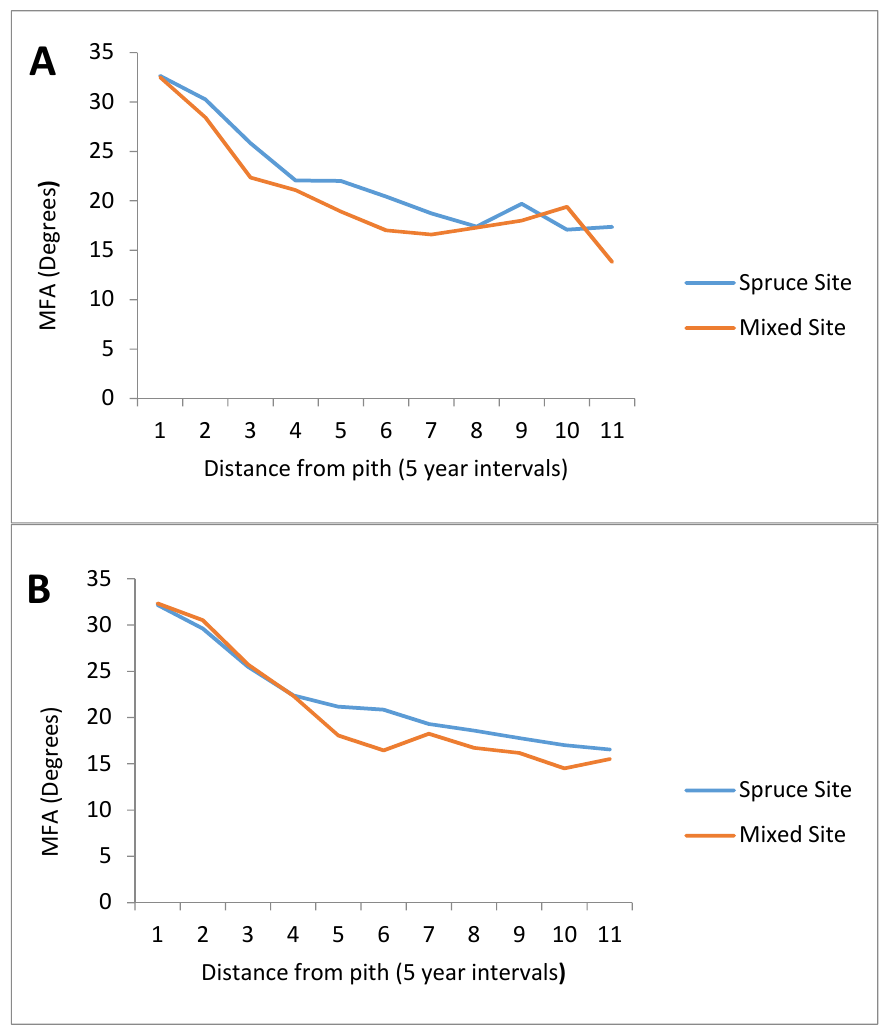
Figure 4. Mean microfibril angle (degrees) at given ages for all dominant ( A ) and co-dominant ( B ) white spruce trees originating from the spruce site (PSP 379) and mixed site (PSP 434). n = 100 for the spruce site, while n = 50 for the mixed site. Overall, the microfibril angle only showed significant changes between sites in trembling aspen